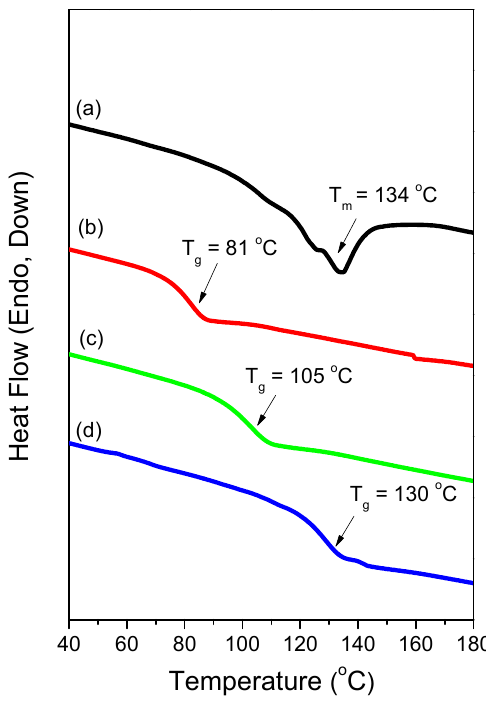
Figure 7. DSC thermograms of: ( a ) MIPOSS-NHBu; ( b ) poly(S- alt -MIPOSS-NHBu); ( c ) poly(AS- alt - MIPOSS-NHBu); and ( d ) poly(HS- alt -MIPOSS-NHBu).